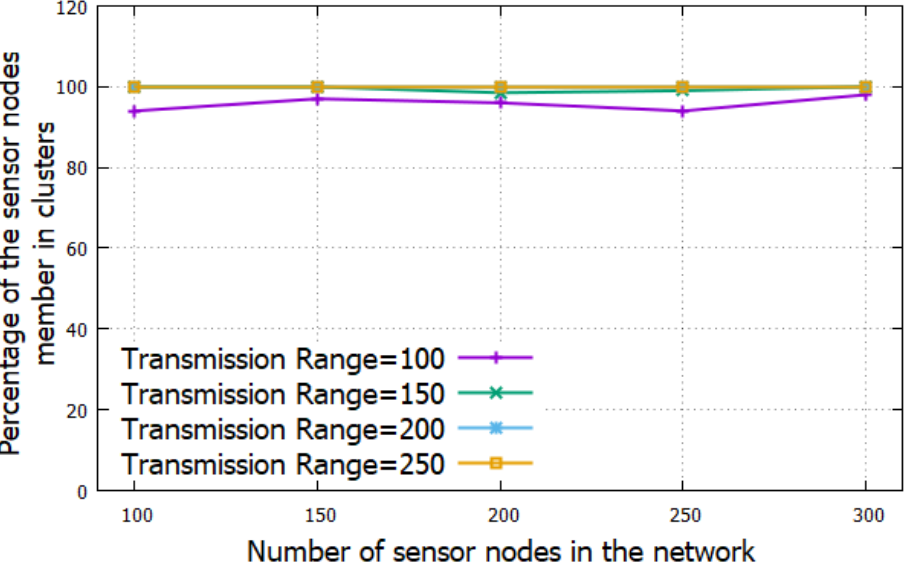
Figure 6. Percentage of the sensor nodes member in clusters as a function of the number of nodes in the network.